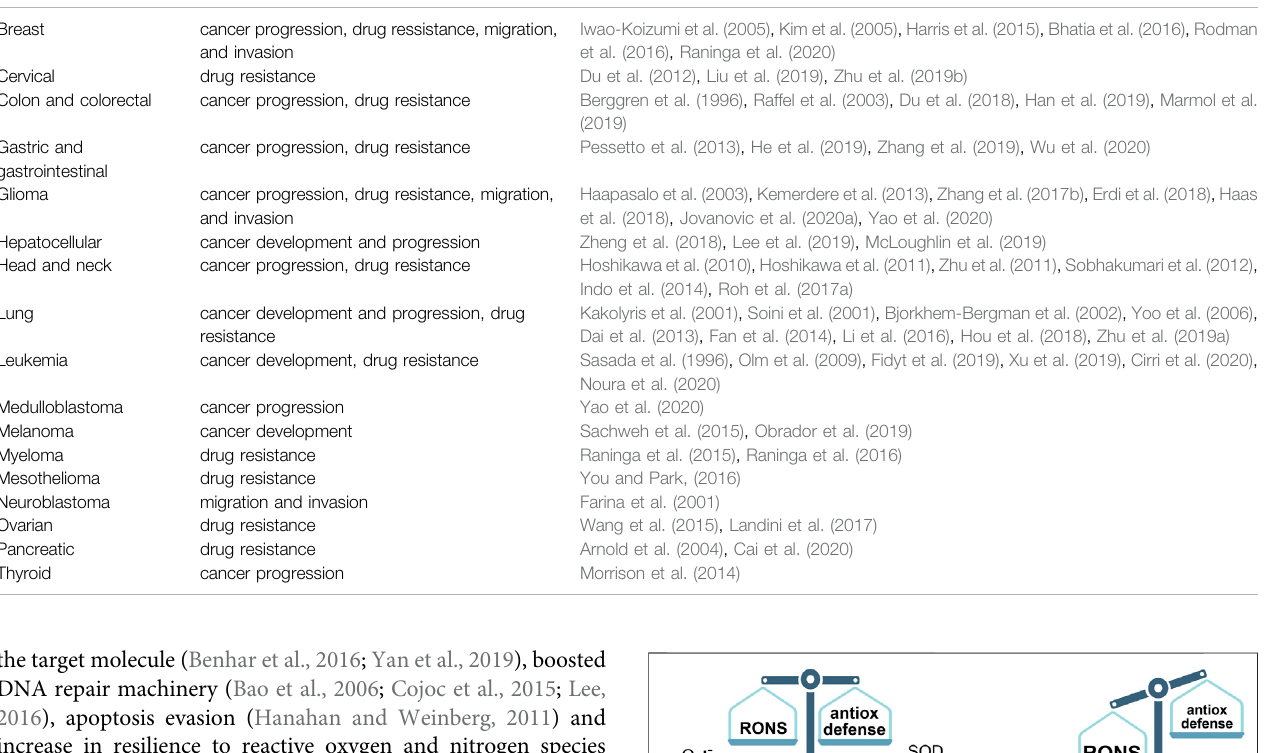
TABLE 1 | The role of the Trx system in speci fi c cancer types. Breast cancer progression, drug ressistance, migration, and invasion Cervical